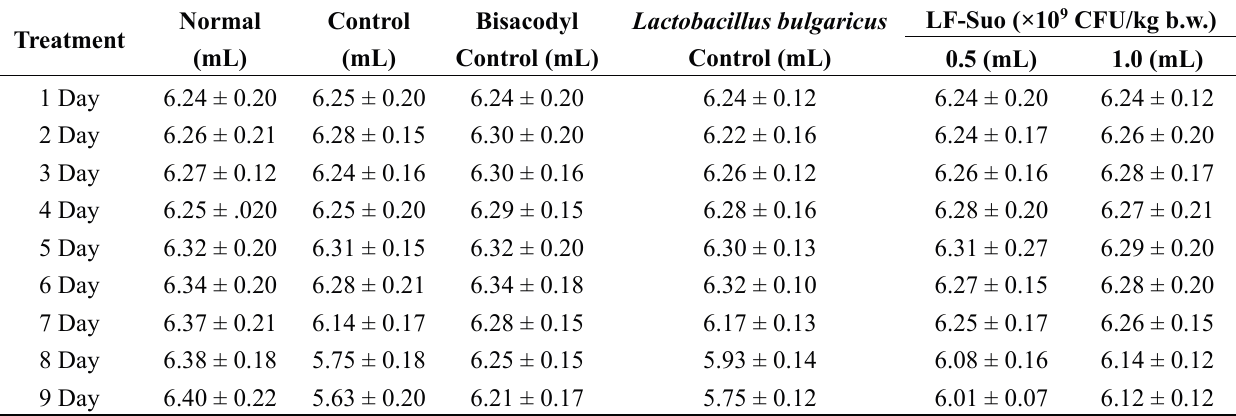
Table 3. Drinking amount of mice during the